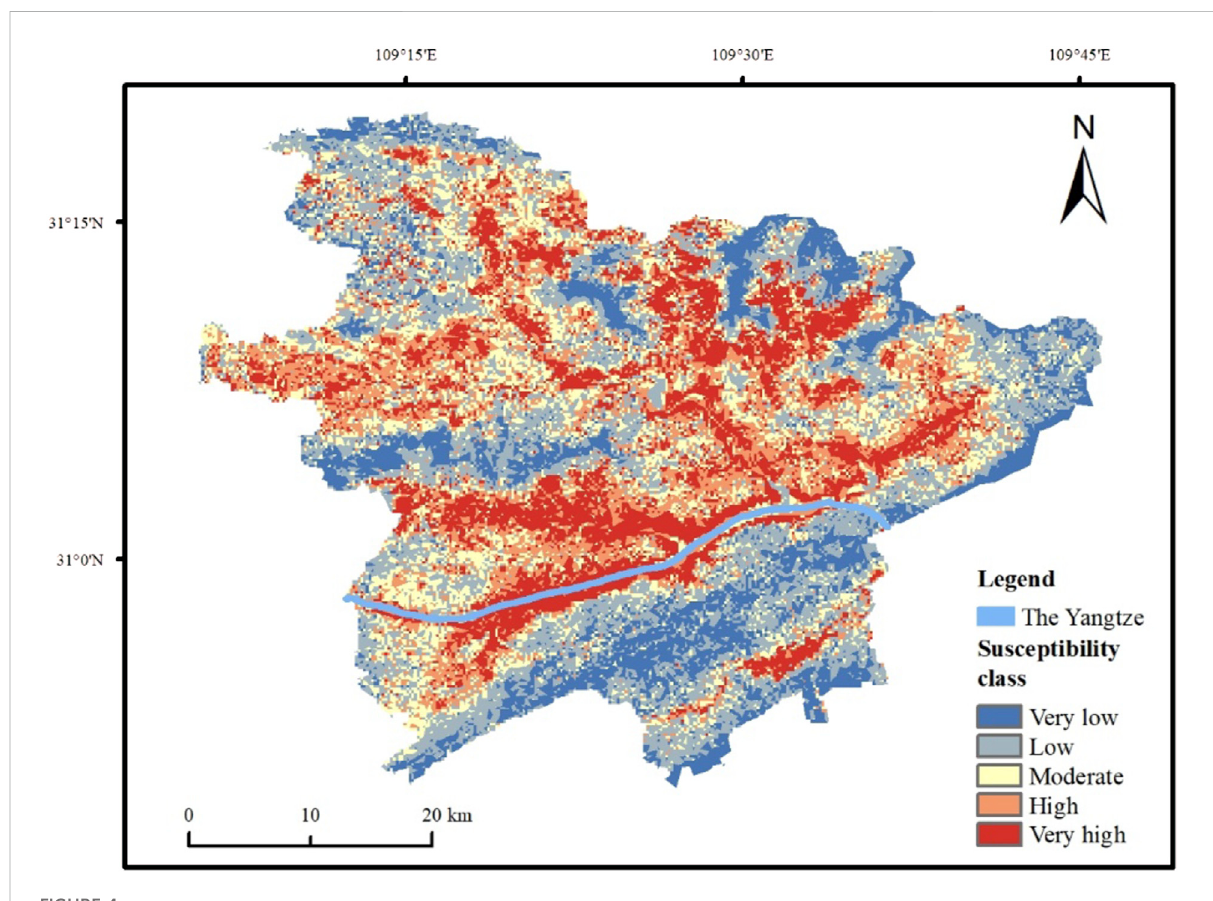
FIGURE 4 Landslide susceptibility map based on